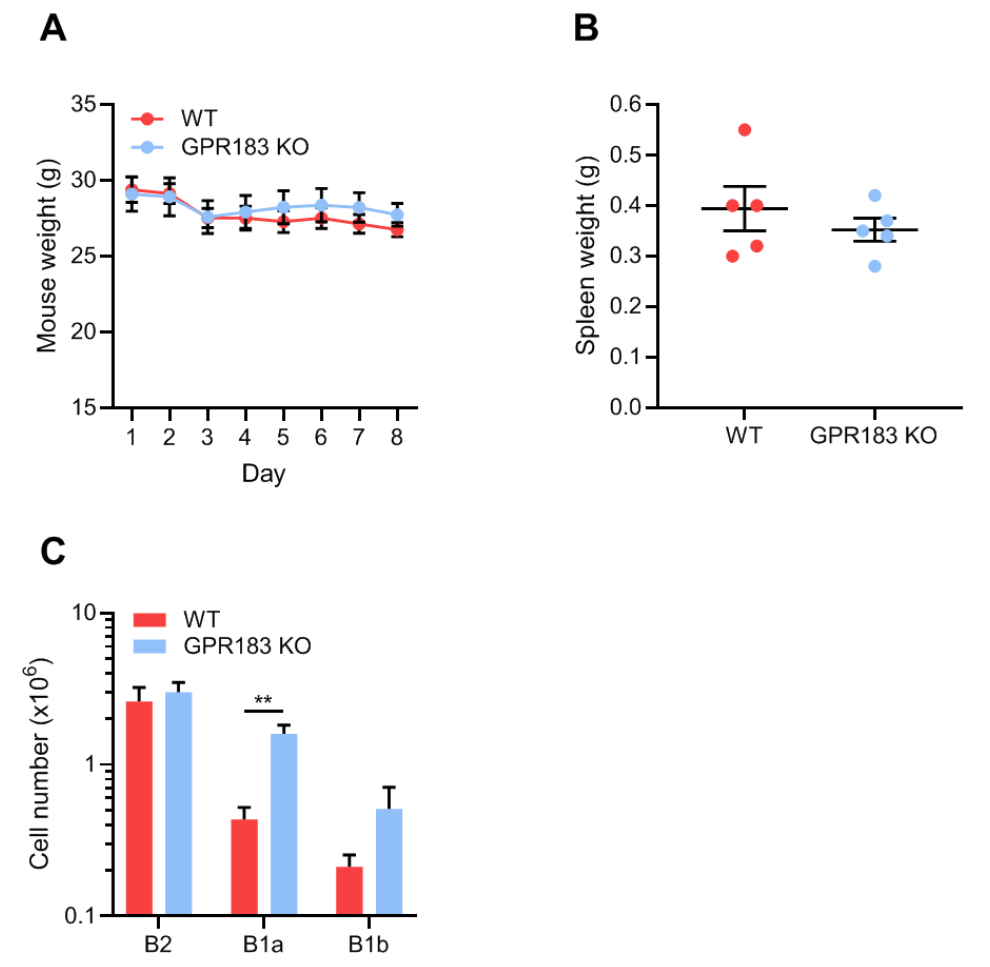
Figure 6. Effects of indomethacin treatment on B cell accumulation in the peritoneal cavity of GPR183 KO mice. GPR183 KO and WT mice were given 10 mg/kg/day indomethacin in their drink-